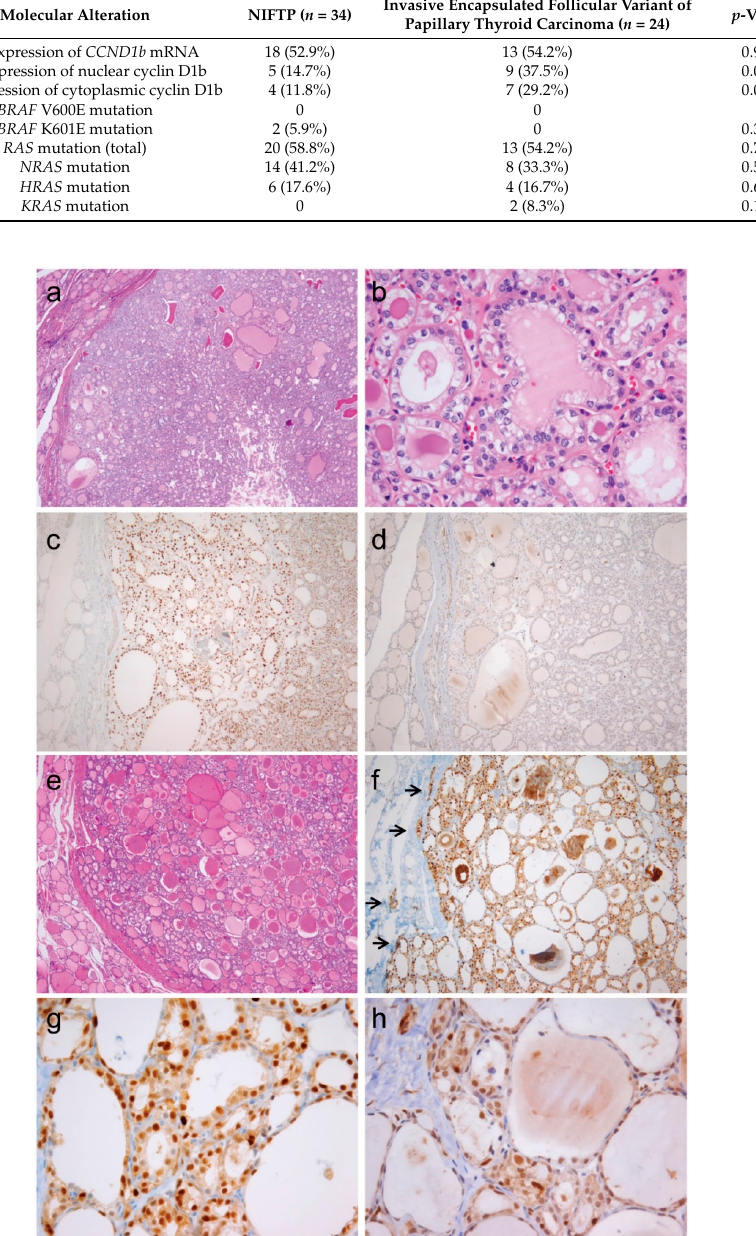
Table 4. Expression of CCND1b mRNA and cyclin D1b protein in an independent cohort of noninvasive follicular thyroid neoplasm with papillary-like nuclear features (NIFTP) and invasive encapsulated follicular variant of papillary thyroid carcinoma.